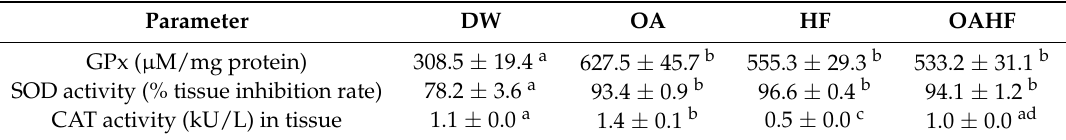
Table 4. The effects of neonatal oral administration of oleanolic acid on the activities of antioxidant enzymes in the skeletal muscles of suckling male and female pups.